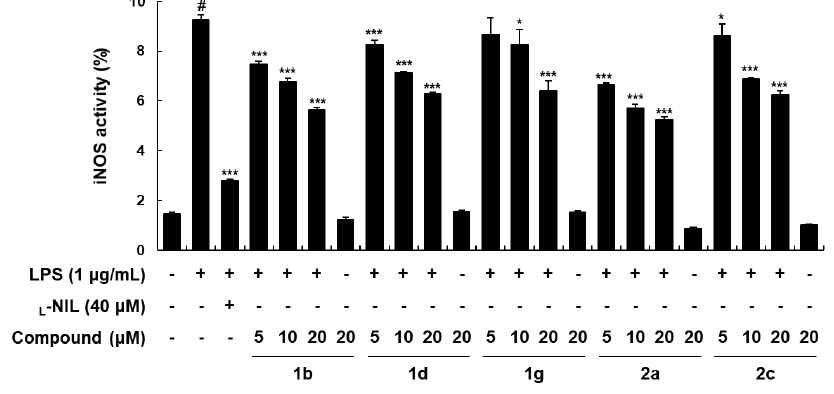
Figure 4. Effect of compounds 1b , 1d , 1g , 2a , and 2c on iNOS activity. Following pretreatment with lipopolysaccharide (LPS, 1 µg/mL) for 12 h and wash with phosphate buffer solution (PBS), cells were treated with 1g (5, 10, or 20 μM) for 12 h N 6 -(1-Iminoethyl)- L -lysine. ( L -NIL) (40 μM) was used as the positive control in the assay. Levels of NO in culture media were quantified using the Griess reaction assay. Data are presented as the means ± SD of three independent experiments. # p < 0.05 versus the control cells; *** p < 0.001 versus LPS-stimulated cells; * statistical significances were compared using ANOVA and Dunnett’s post hoc test.